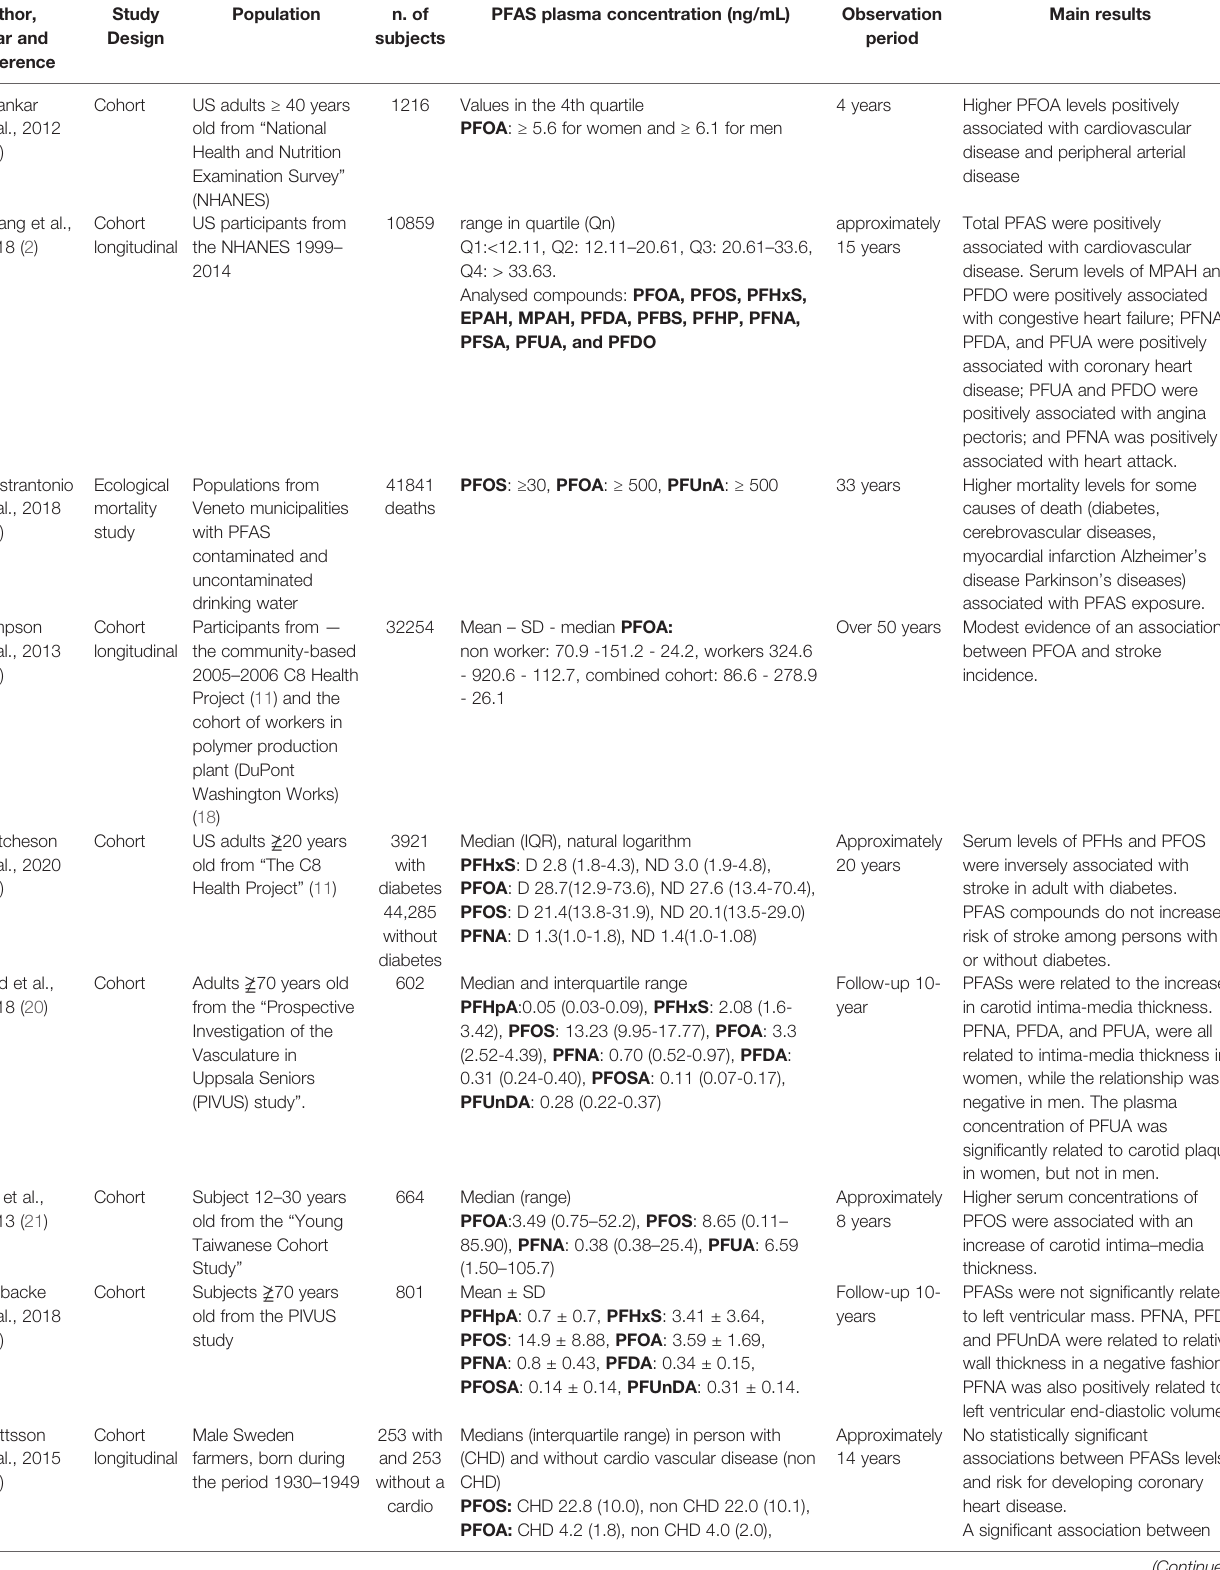
TABLE 1 | Clinical and epidemiological studies exploring the rule of PFAS in cardiovascular disease and cardiovascular risk